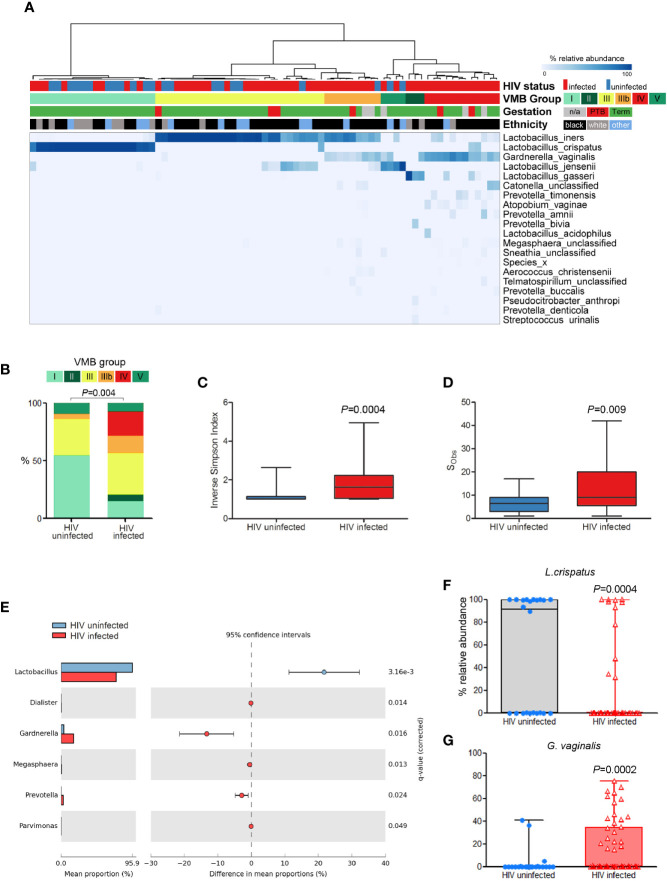
Comparison of vaginal microbiota composition of PWLWH (n = 53) and HUPW (n = 22) sampled during the second trimester of pregnancy. (A) Hierarchical clustering (Ward linkage) of relative abundance data of vaginal bacterial species identified six major vaginal microbiota (VMB) groups, with HIV status, ethnicity, and gestation at delivery for each patient presented above the heat map. (B) Proportions of VMB types differed significantly between PWLWH and HUPW with the former characterised by increased bacterial (C) diversity and (D) richness. (E) Compared to HUPW, samples from PWLWH had lower relative abundance of Lactobacillus spp. and Gardnerella spp. which were largely driven by significantly lower proportions of L crispatus
(F) and higher proportions of G. vaginalis
(G).